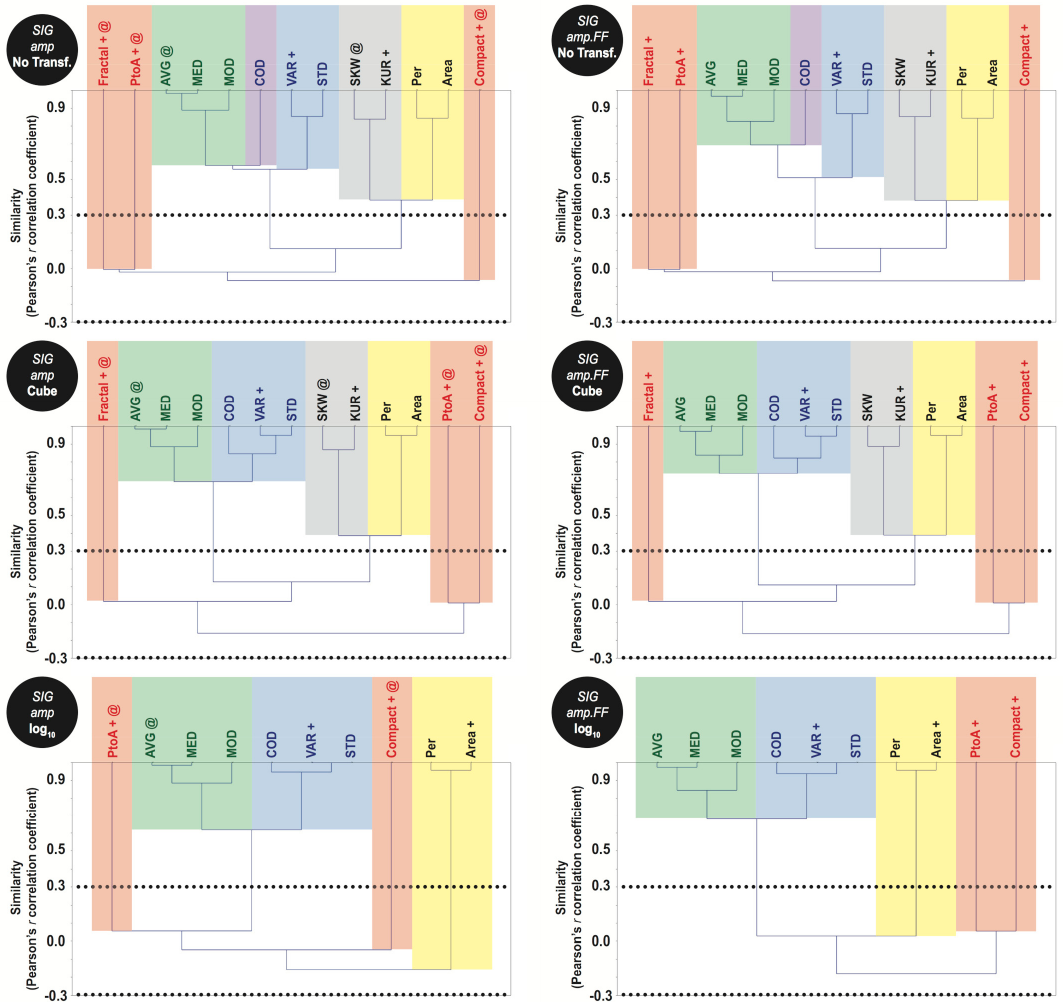
Figure 4. Unweighted pair group method with arithmetic mean (UPGMA) dendrogram analyses for sigma–naught ( σ ◦ ) given in amplitude ( amp ), without (left) and with (right) a despeckle filter ( FF ; for Frost filter [62]), for the tested non-linear transformations: none (top), cube root (middle), and log 10 (bottom). Dotted lines: strict similarity phenon thresholds ( r = 0.3 and − 0.3). Yellow and red: size information (basic morphological characteristics and their ratios, respectively). Green and blue: SAR basic qualitative-quantitative statistics (central tendencies and dispersion, respectively). Gray: pixel distribution metrics. Uncorrelated variables ( + ) selected in our current research; see also Table 4. The (@) indicates those explored in the first refined study ( amp instances only [31,32]). For an explanation of the attributes, see Section 3.1.